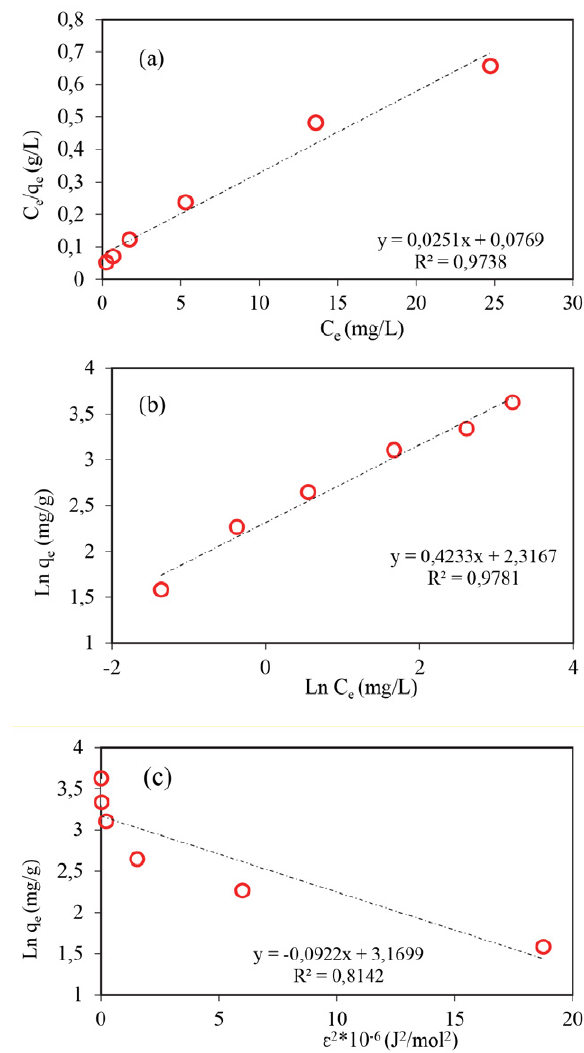
Figure 10. Sorption isotherms of P ions using the Langmuir (a), Freundlich (b) and D-R (c) models (Conditions: pH = 6, MnFe 2 O 4 dose = 2 g/L, temperature = 55 °C, time = 60 min, mixing rate = 500